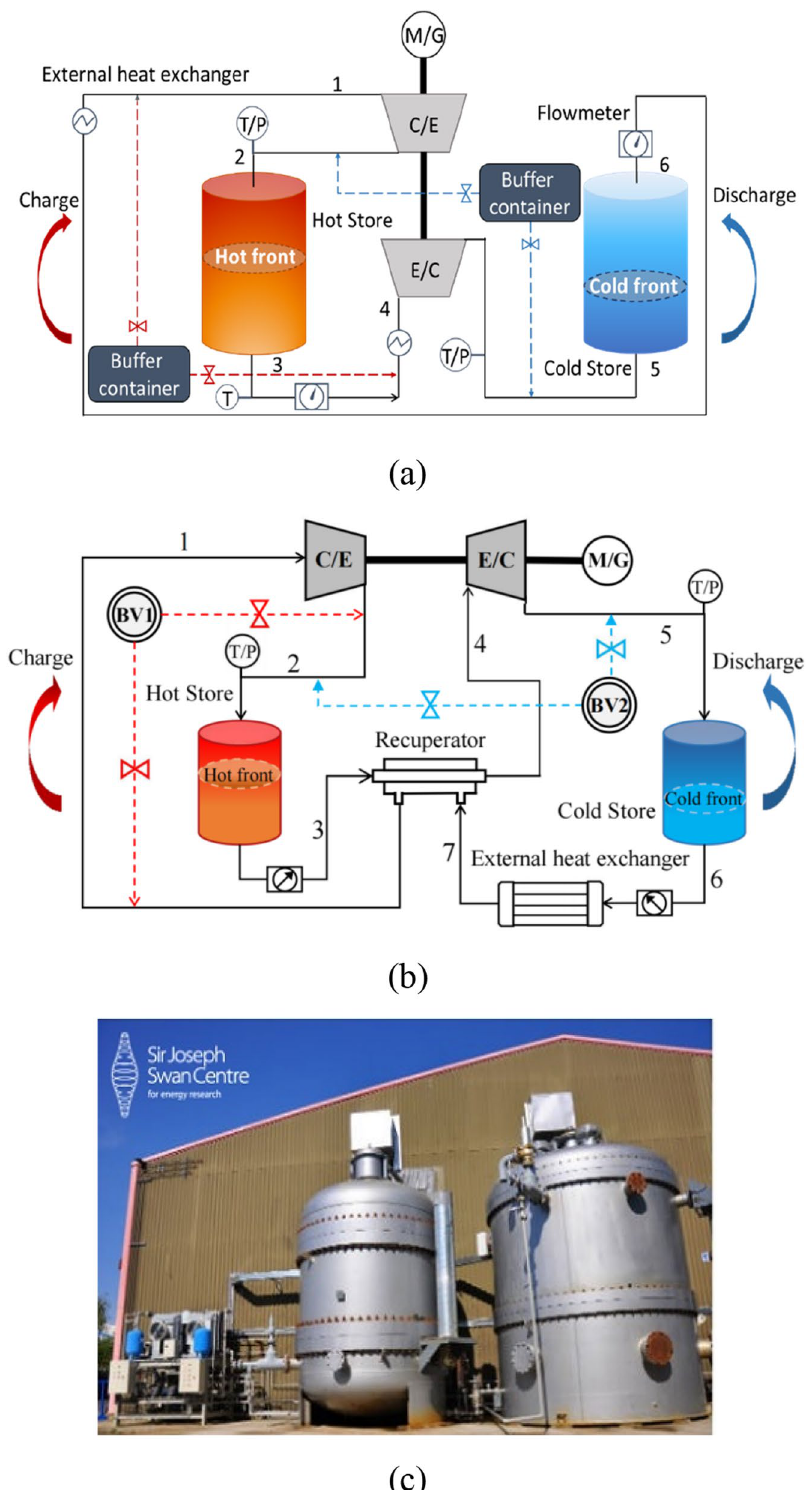
Fig. 17 Representative Carnot battery system design and experimental layout: a PTES based on packed-bed latent heat/cold stores, b Brayton-like recuperated PTES system and c the PTES system at Newcastle’s Joseph Swan Centre, with the two tanks filled with mineral particulate [273, 274,